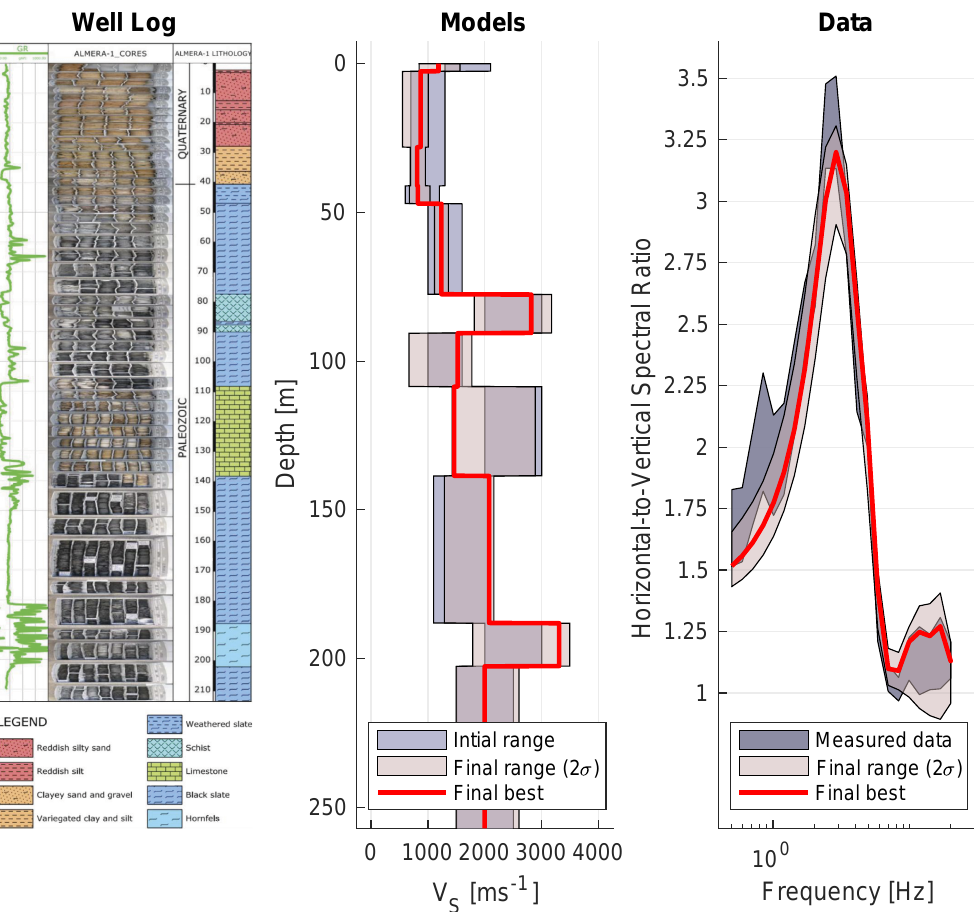
Figure 4. Well-log, models and data for ICJA station obtained with FFT. Well-log column taken from